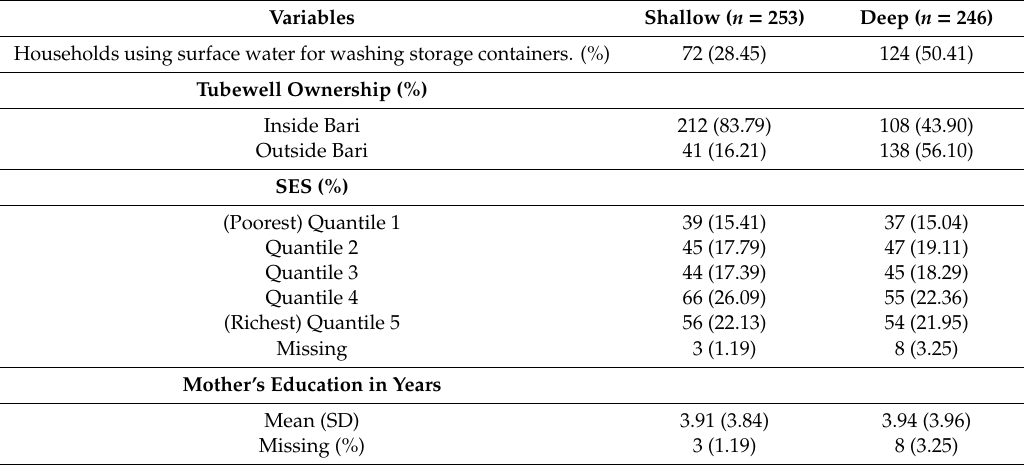
Table 1. Summary of Households by Tubewell Type.